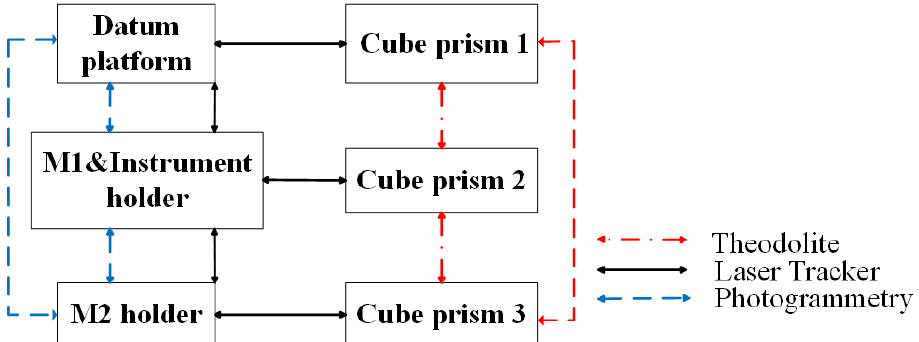
Figure 13. Coordinate system transfer method.